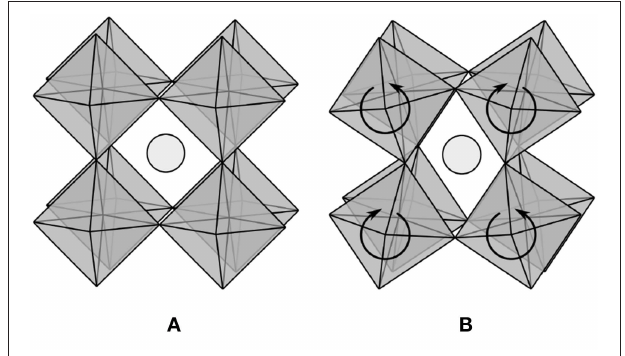
FIGURE 1 | (A) Perovskite materials with formula ABO 3 contain a regular network of corner-sharing BO 6 octahedra, with the position of the A atom in light gray. (B) Patterns of octahedral tilting (Glazer, 1972) are low-frequency modes of the